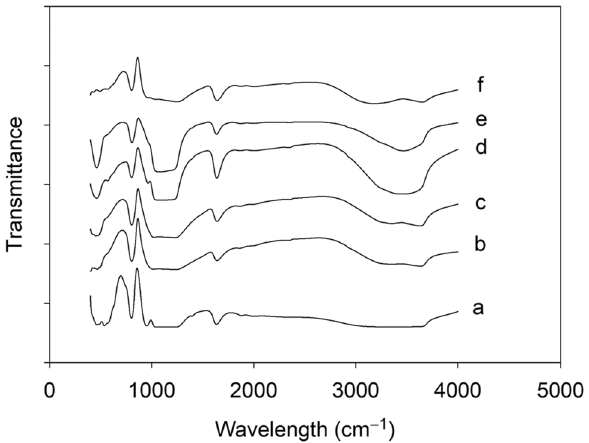
Fig. 8 FTIR spectra of the catalysts: a B300, b BC11.1, c BC5.7, d BC48, e BC0.7, and f